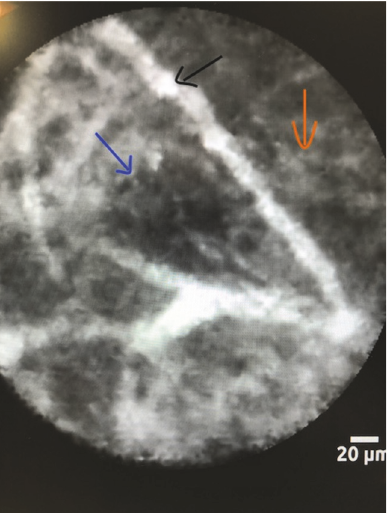
Figure 3: EUS guided needle based confocal laser endomicroscopy reveals clusters of cells (blue arrow) with surrounding areas of fibrosis (orange arrow) and vascularity (black arrow).